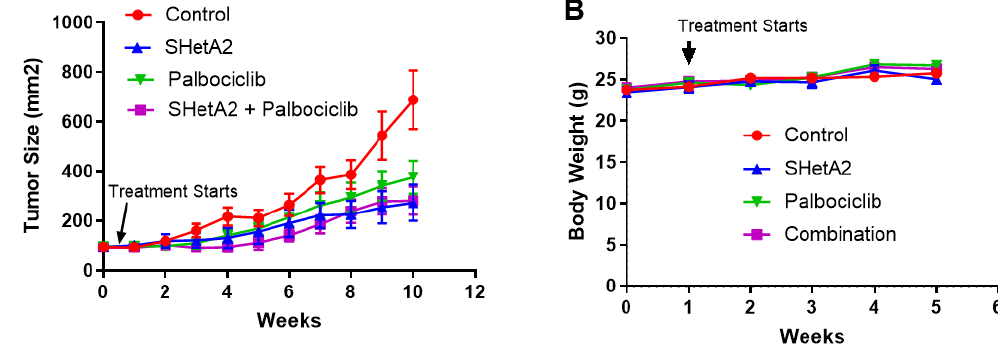
Figure 4. Effect of control, SHetA2, palbociclib, and combination treatments on average tumor size ( A ) and body weight ( B ) in SiHa xenograft tumor bearing mice.